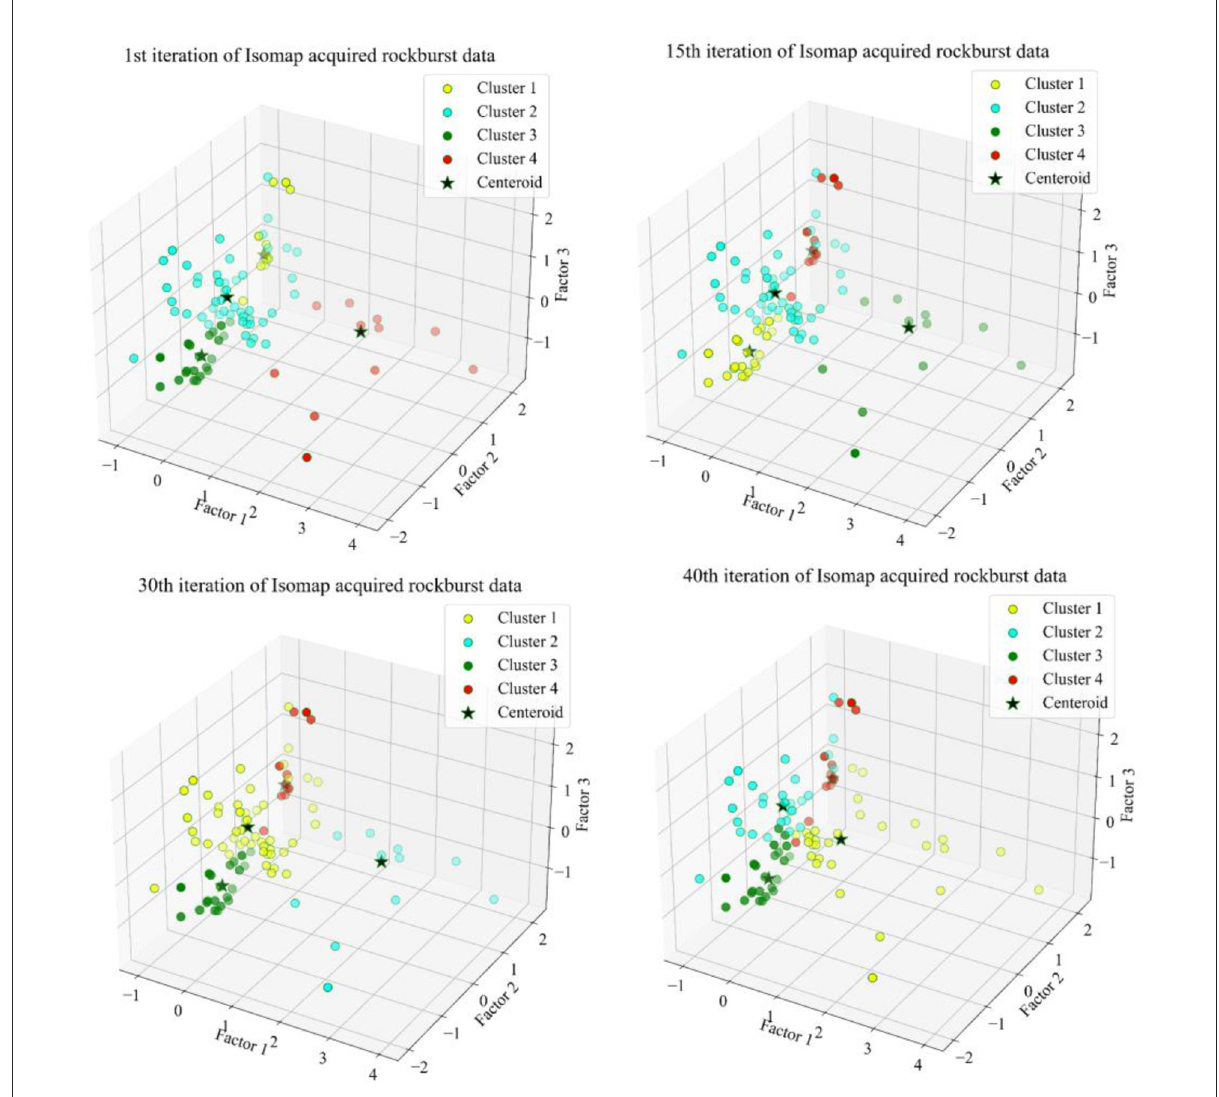
FIGURE8 Fuzzy c-means algorithm visualization on Isomap database.